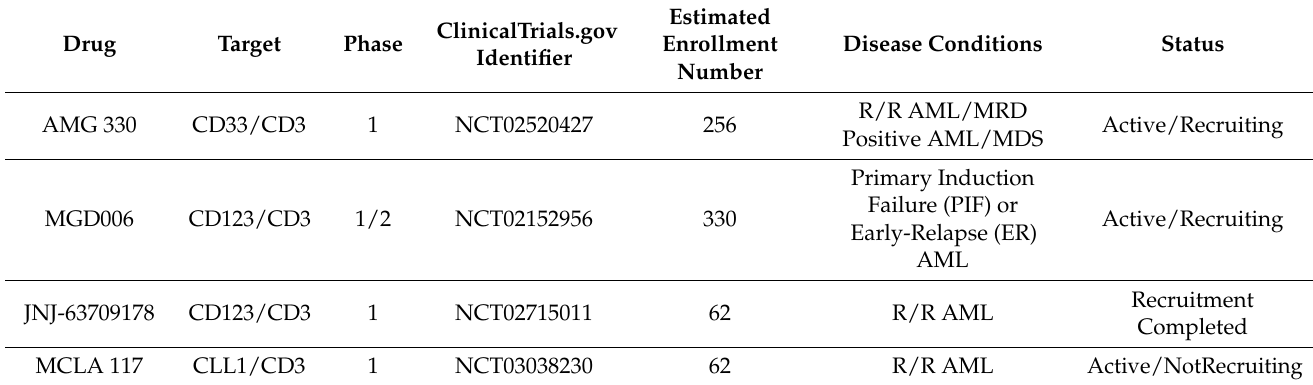
Table 1. Clinical trials of bispecific antibodies for leukemia